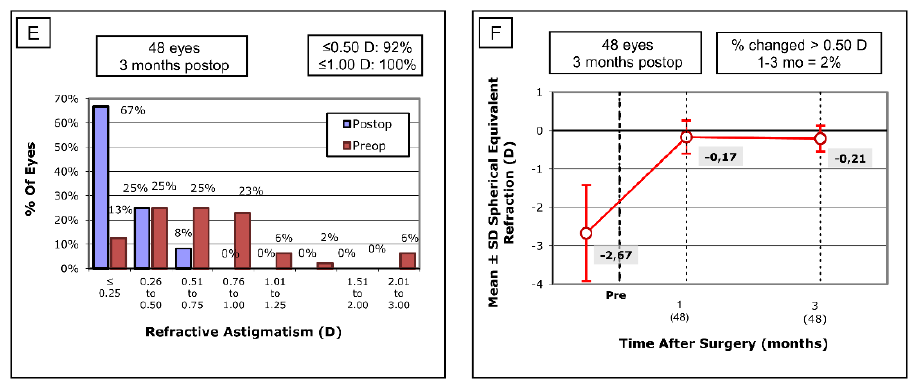
Figure 1. Standard graphs for reporting refractive surgery. ( A ) Uncorrected visual distance acuity (UDVA)–efficacy histogram. ( B ) Change in corrected distance visual acuity (CDVA)–safety histogram. ( C ) Spherical equivalent attempted versus achieved. ( D ) Spherical equivalent refractive accuracy. ( E ) Refractive astigmatism. C–E graphs represent predictability. ( F ) Stability of spherical equivalent